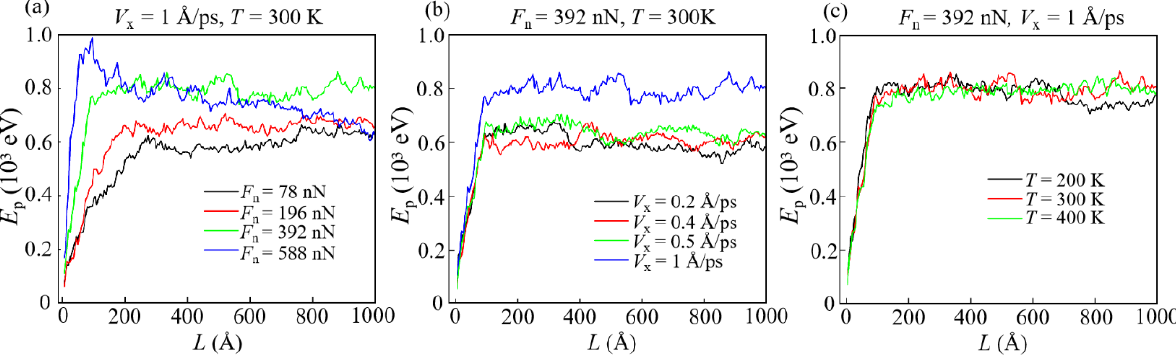
Figure 8. The evolution of plastic potential E p under different conditions: ( a ) V x = 1 Å/ps, T = 300 K; ( b ) F n = 392 nN, T = 300 K; ( c ) F n = 392 nN, V x = 1 Å/ps.